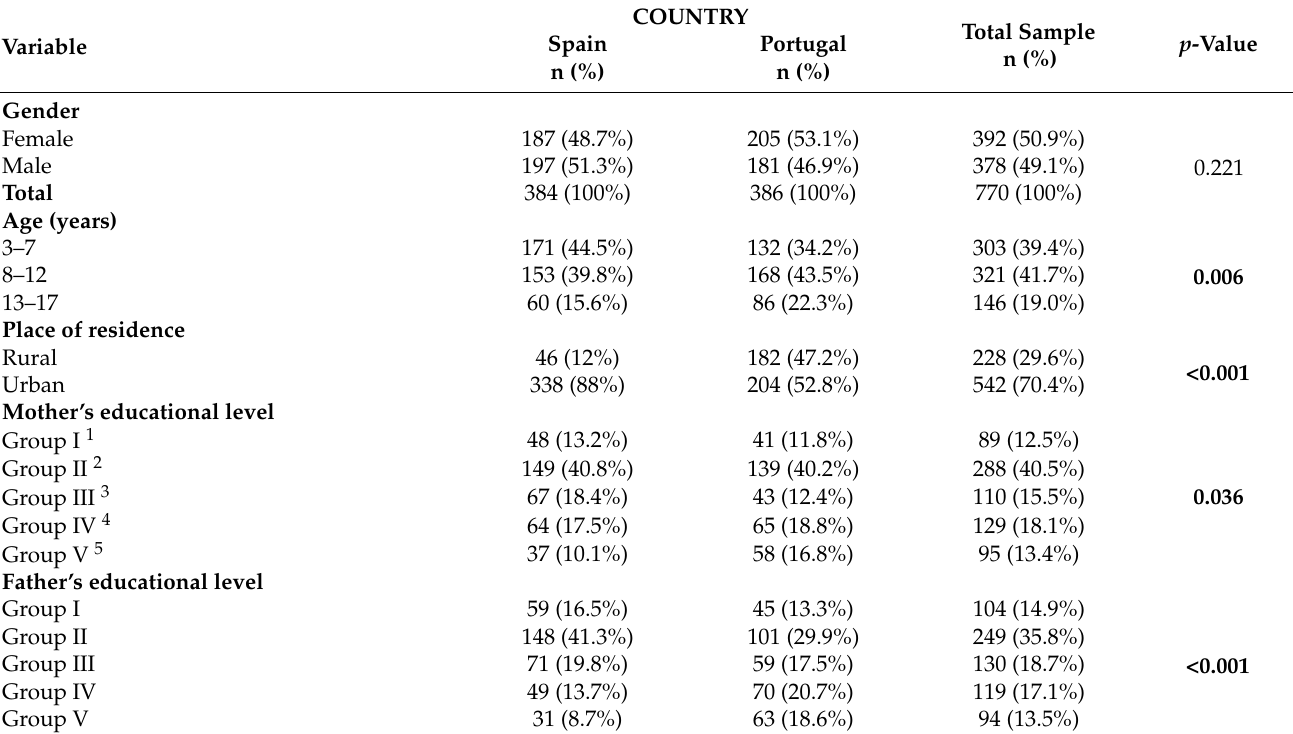
Table 1. Study sample characterization: sociodemographic features and impact of the lockdown on the child and family’s